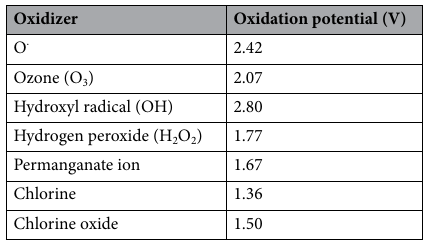
Table 1. Oxidation potentials of major reactive radicals or oxidizers.